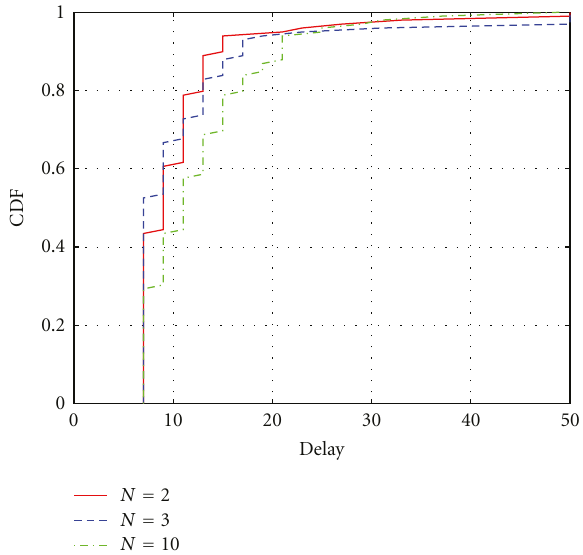
Figure 15: CDF of performance gain over the random Q values in partial observation